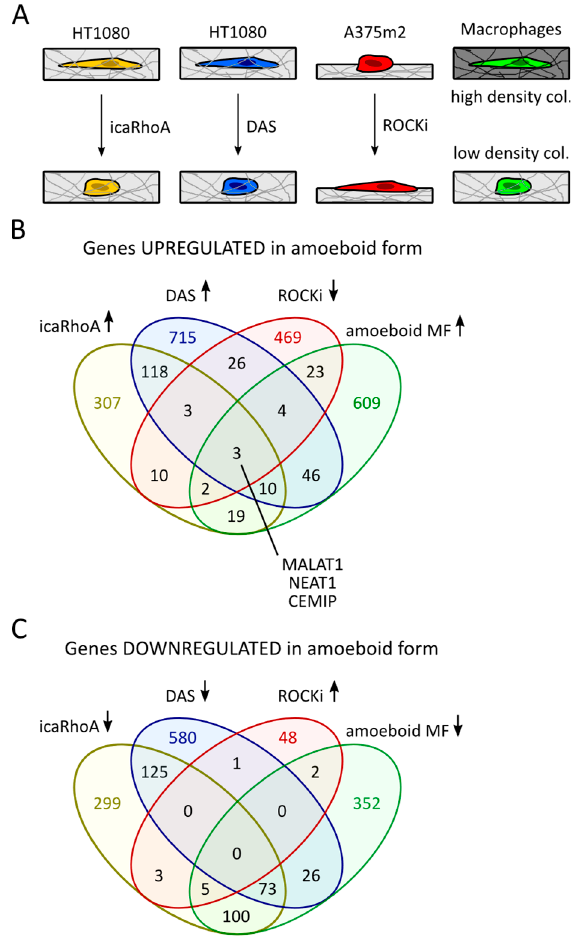
Figure 1. Comparison of published transcriptomic profiles of amoeboid cells in 3D conditions. ( A ) The schematic representations of experimental systems used in the comparison of datasets. ( B ) Venn diagram of gene sets upregulated in the amoeboid HT1080 cells (manuscript in revision) and macrophages [29], and suppressed in A375m2 cells by ROCK inhibitors (ROCKi) [28]. ( C ) Venn